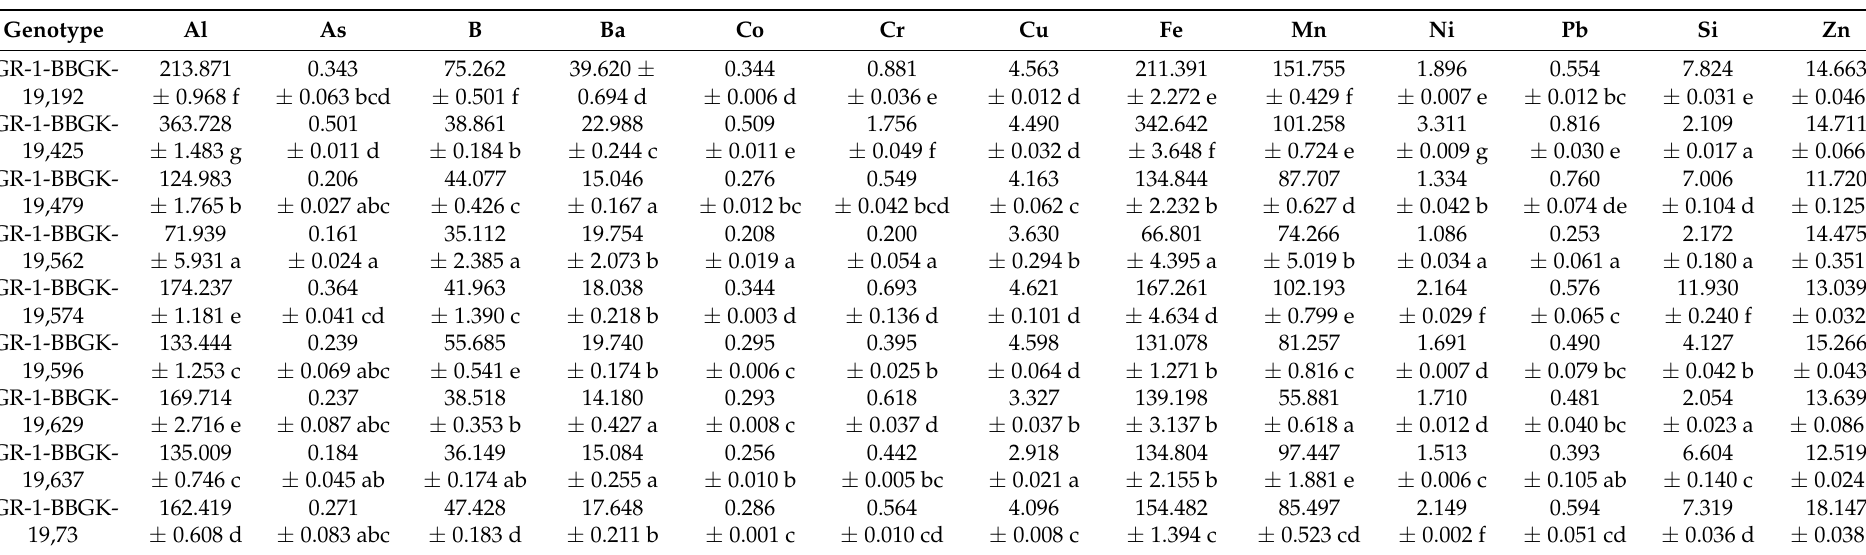
Table 3. Concentrations of micro-elements measured in leaves of cultivated germplasm of nine Greek Sambucus nigra genotypes ( µ g g − 1 DW ± SD, n = 3).